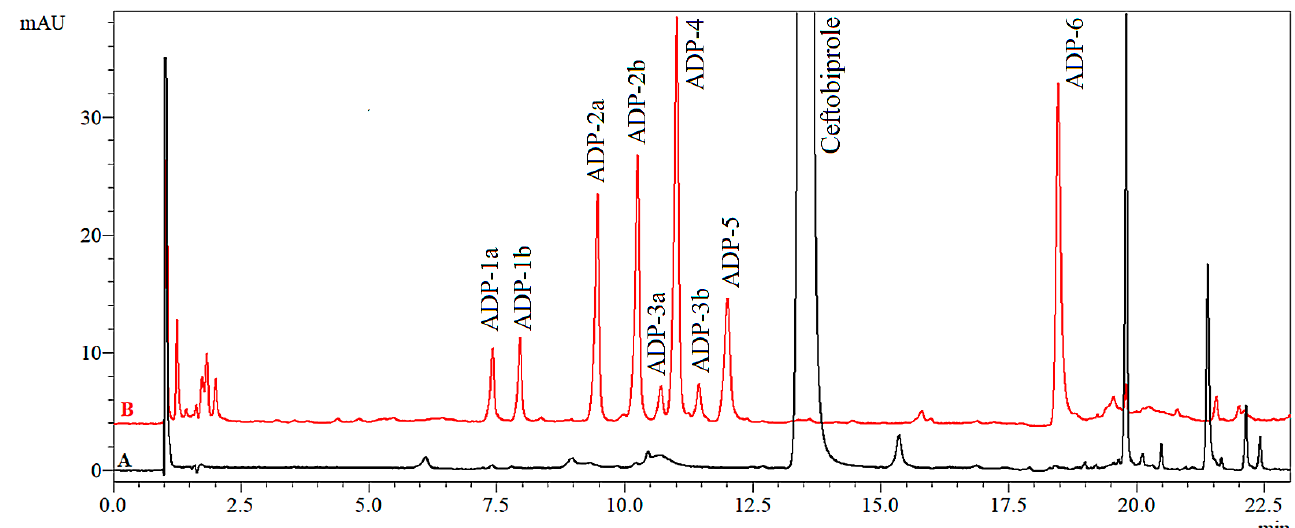
Figure 3. Overlaid chromatograms obtained from the separation of a 1 mg/mL solution of ceftobiprole by acidic hydrolysis in 1 M HCl: ( A ) at time 0; ( B ) after incubation at 70 °C for 360 min.